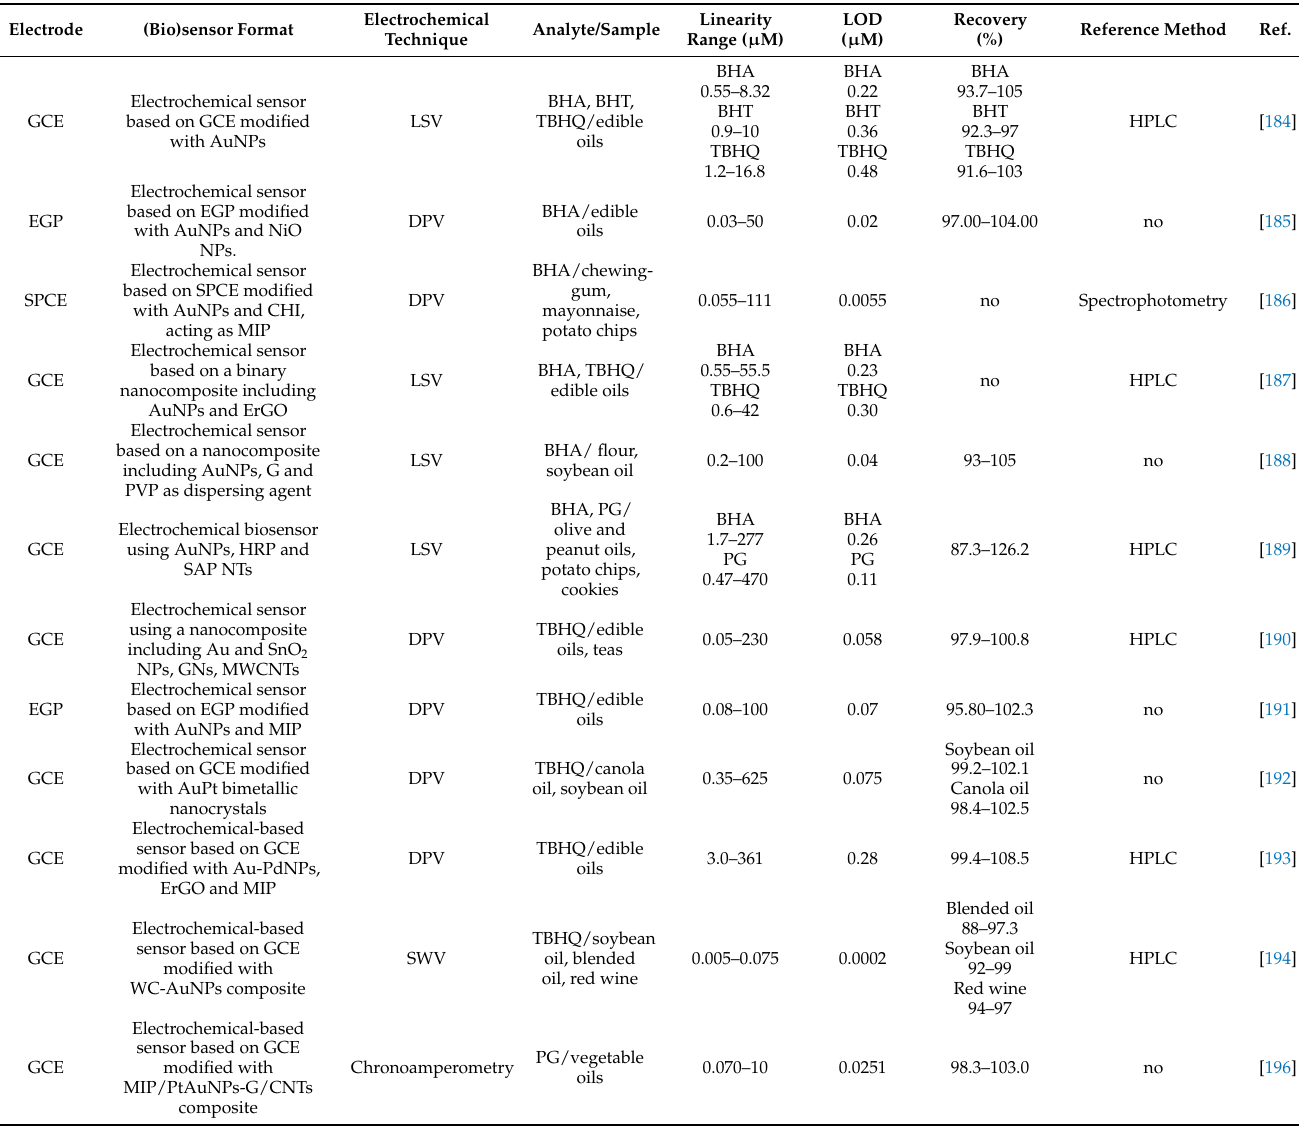
Table 4. Performances of electrochemical sensors for synthetic phenolic antioxidant